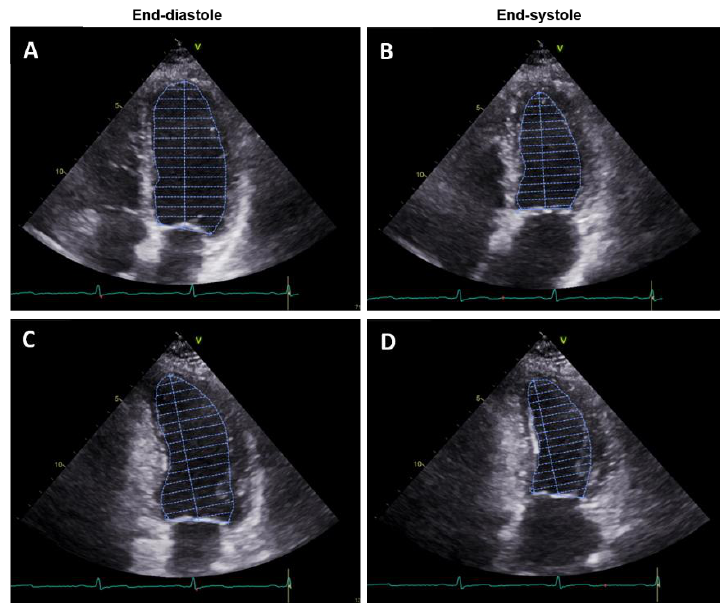
Figure 1. Apical 4-chamber ( A , B ) and 2-chamber ( C , D ) transthoracic echocardiography in end-diastole ( A , C ) and end-systole ( B , D ) showing the biplane method of disks for the assessment of left ventricular ejection fraction.